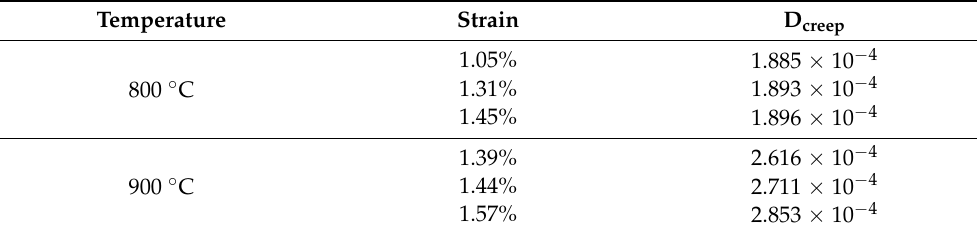
Table 5. Creep damage per cycle at various temperature and strain values.